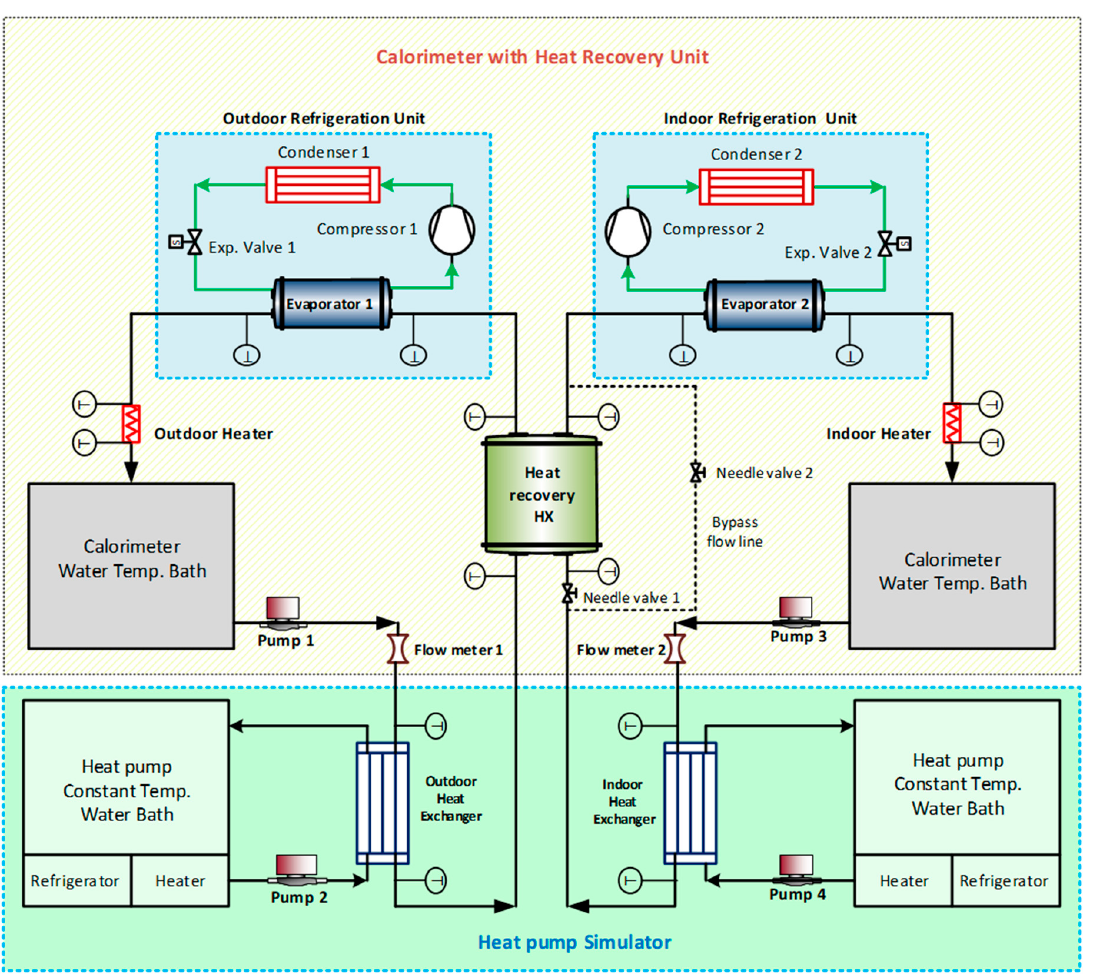
Figure 2. Newly developed calorimeter test rig for a water-to-water heat pump.